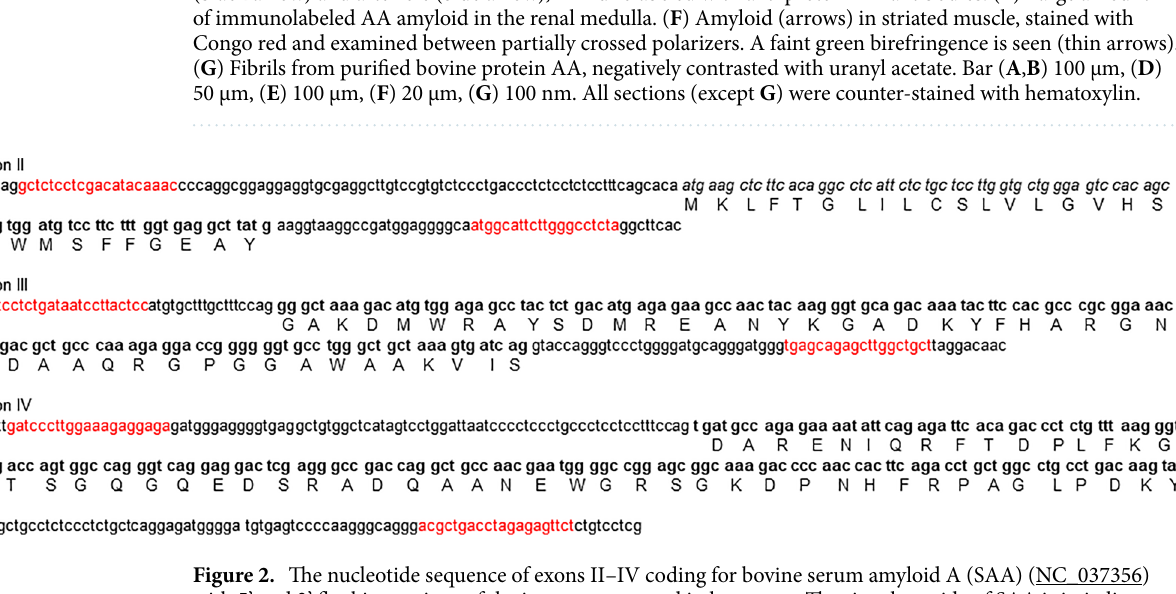
Figure 2. The nucleotide sequence of exons II–IV coding for bovine serum amyloid A (SAA) (NC_037356) with 5’ and 3’ flanking regions of the introns, presented in lowercase. The signal peptide of SAA is in italic, the mature SAA peptide in bold, and the primer binding sequences are indicated in red. Uppercase letters correspond to the one-letter code of the SAA amino acid